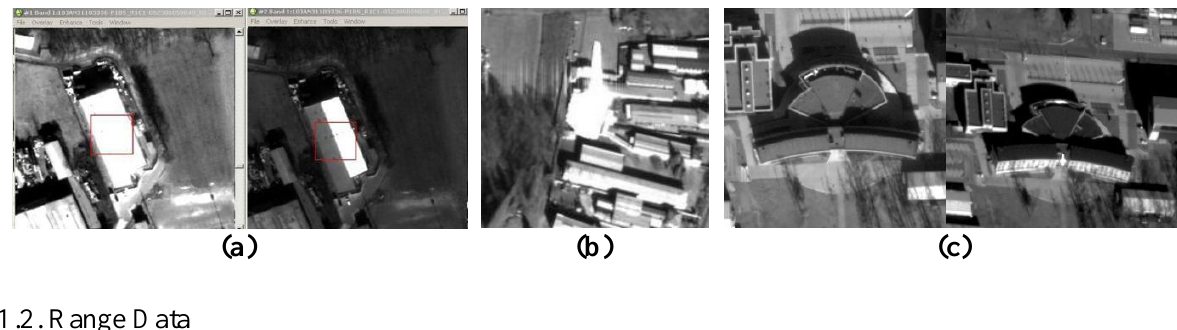
Figure 6. Typical artefacts and problems in satellite imagery (here a WorldView-2 stereo-pair): saturation (a) , spilling (b) and scale (c)